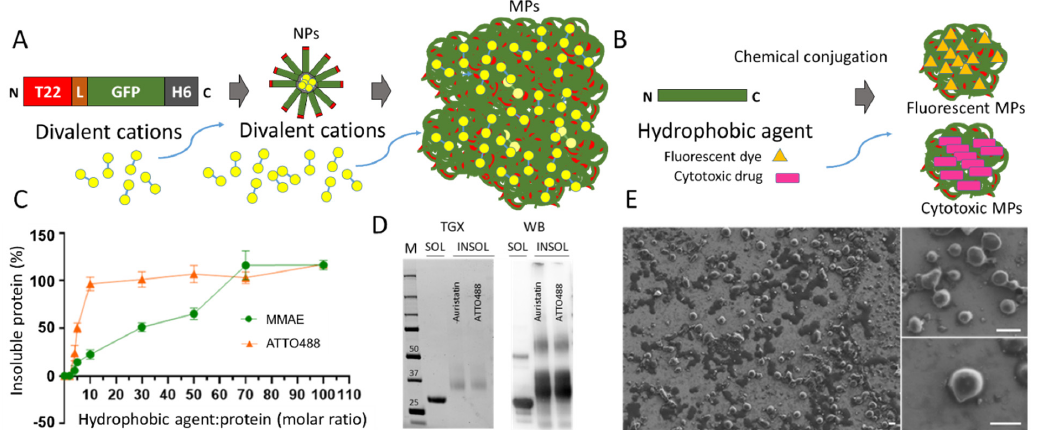
Figure 1. Fabrication of protein–drug microscale depots. ( A ). The modular protein T22 ‐ GFP ‐ H6